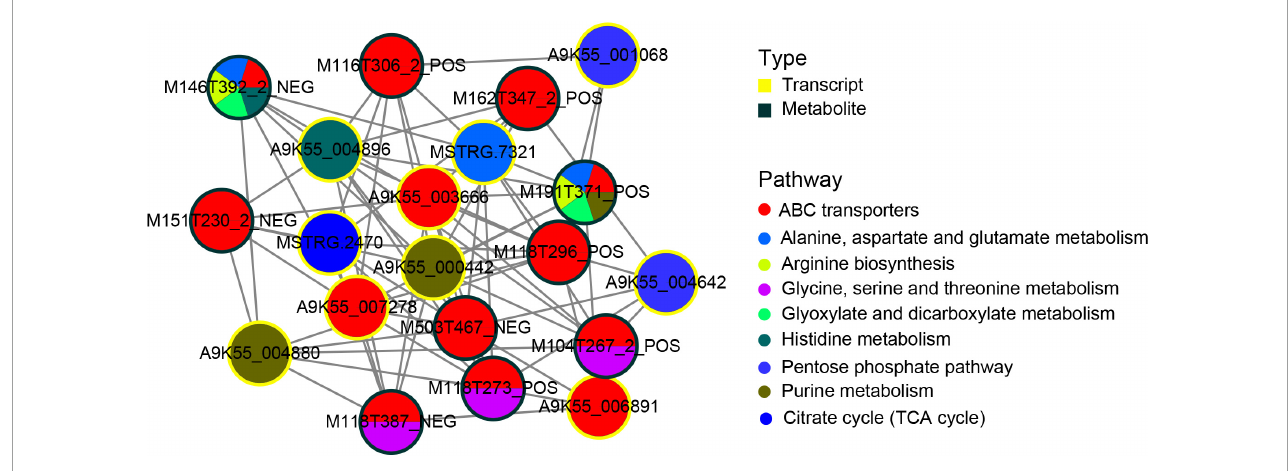
FIGURE6 Transcript-metabolite Pearson’s correlation network representing differentially abundant metabolites (DAMs) and DEGs involved in C. militaris . Gene–metabolite pairs are connected by edges within the network. The yellow nodes represent genes and the green nodes represent metabolites. Edges between nodes represent correlations. The top 205 relationship pairs with correlation coefficient values were included in the network, and only the top 10 genes and top 10 metabolites are shown in the figure. The pie chart on the node shows a part of the pathways involved in DAMs and DEGs.